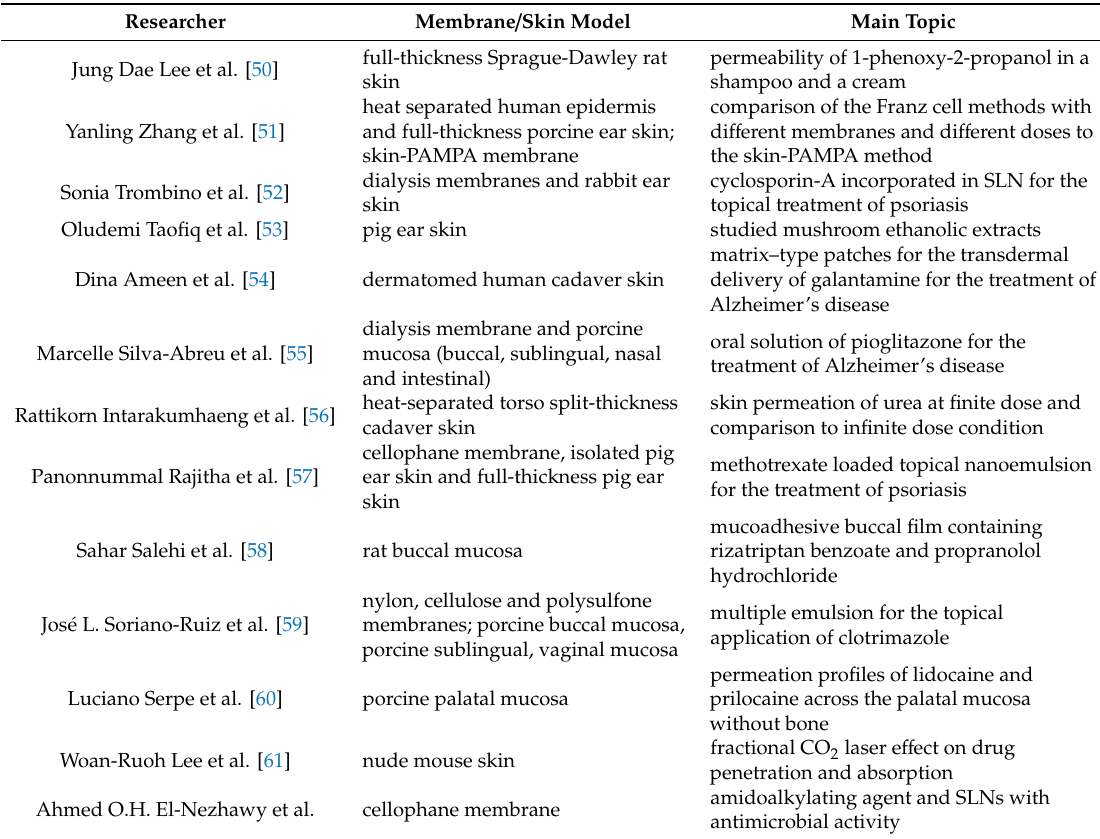
Table 2. Some Franz di ff usion measurements (last 4